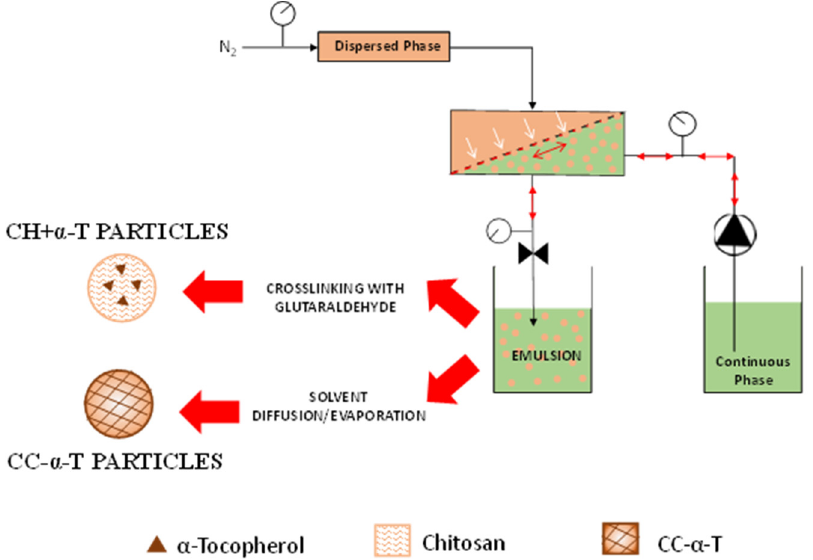
Figure 4. Membrane-emulsification plant used to produce W/O and O/W emulsions and solid particles obtained by cross-linking reaction (CH+ α -T particles) and solvent diffusion/evaporation (CC- α -T particles).